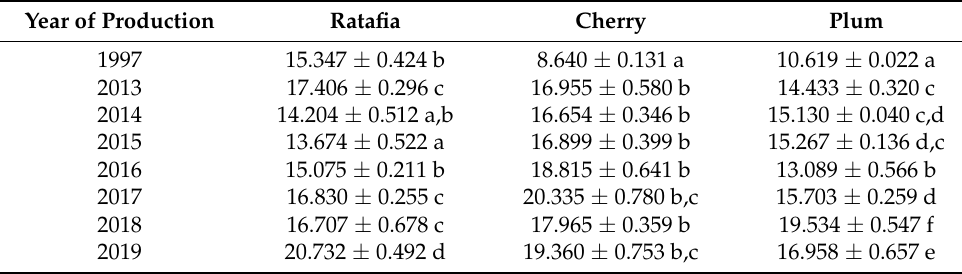
Table 4. The antioxidant activity of nalewkas was measured by the CUPRAC method (mean ± SD, n = 3). Different letters indicate significant differences between the individual years. The result was expressed in mg Trolox · g − 1 of